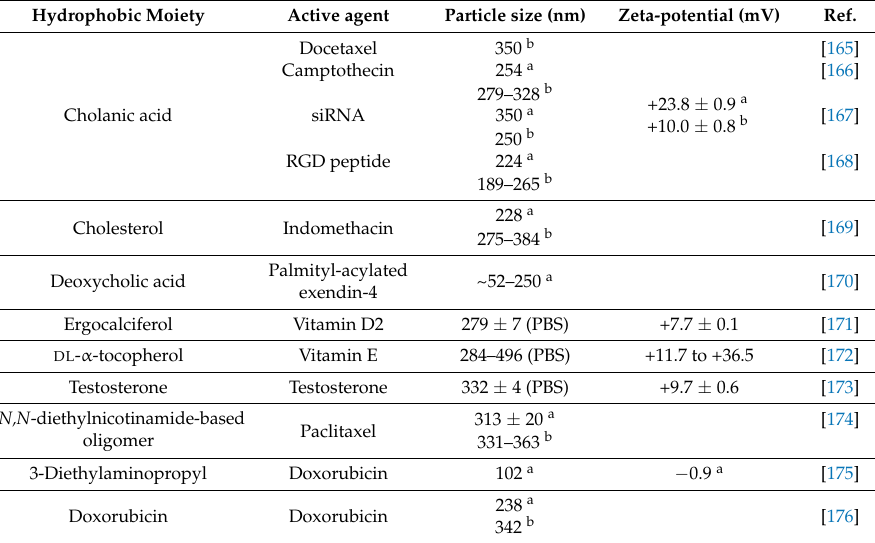
Table 5. Hydrophobically modified glycol